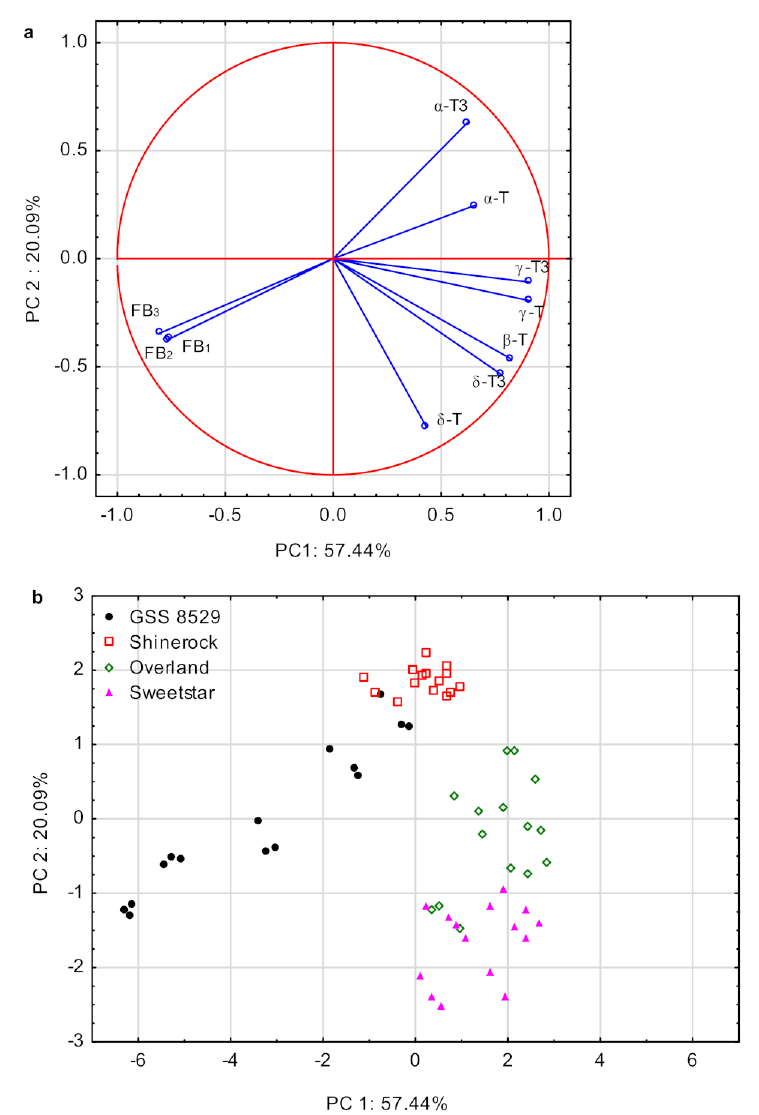
Figure 2. Projections of the variables ( a ) and scores ( b ) onto the factor plane defined by principal components (PC1 and PC2). Note: FB 1 , FB 2 , FB 3 —fumonisins B 1 , B 2 and B 3 , respectively; α -T3, δ -T3, γ -T3—tocotrienols alfa, delta and gamma, respectively; α -T, β -T, δ -T, γ -T tocopherols, alfa, beta, delta and gamma,